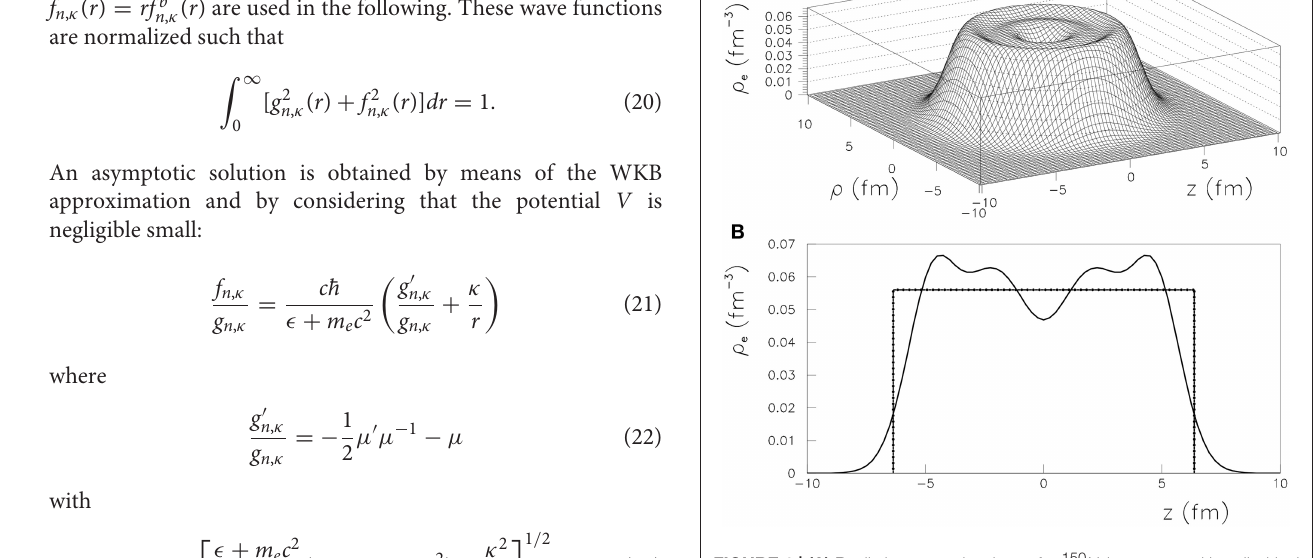
FIGURE 1 | (A) Realistic proton density ρ e for 150 Nd represented in cylindrical coordinates ρ and z . (B) Profile of the realistic proton density ρ e for 150 Nd (thick line) compared with that given with the constant density approximation (dot-dashed line).